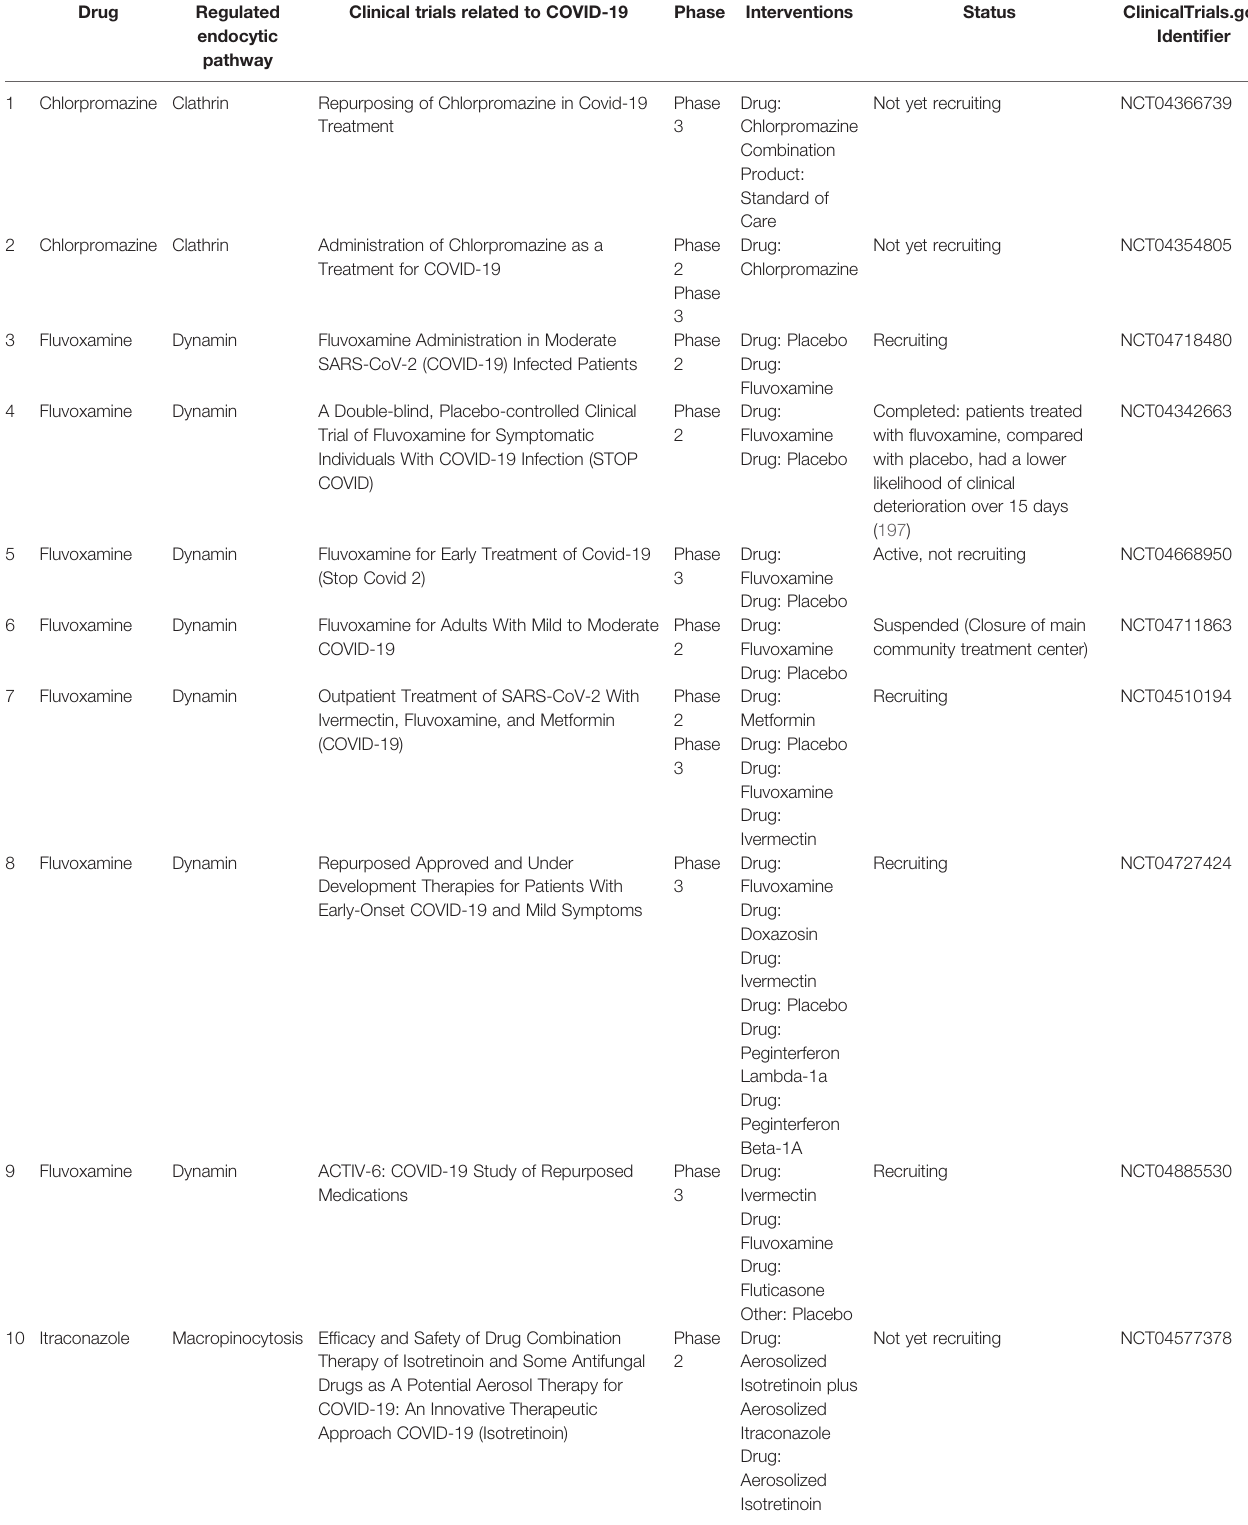
TABLE 1 | Clinical trials of potential endocytosis and transcytosis inhibitors and modulators.